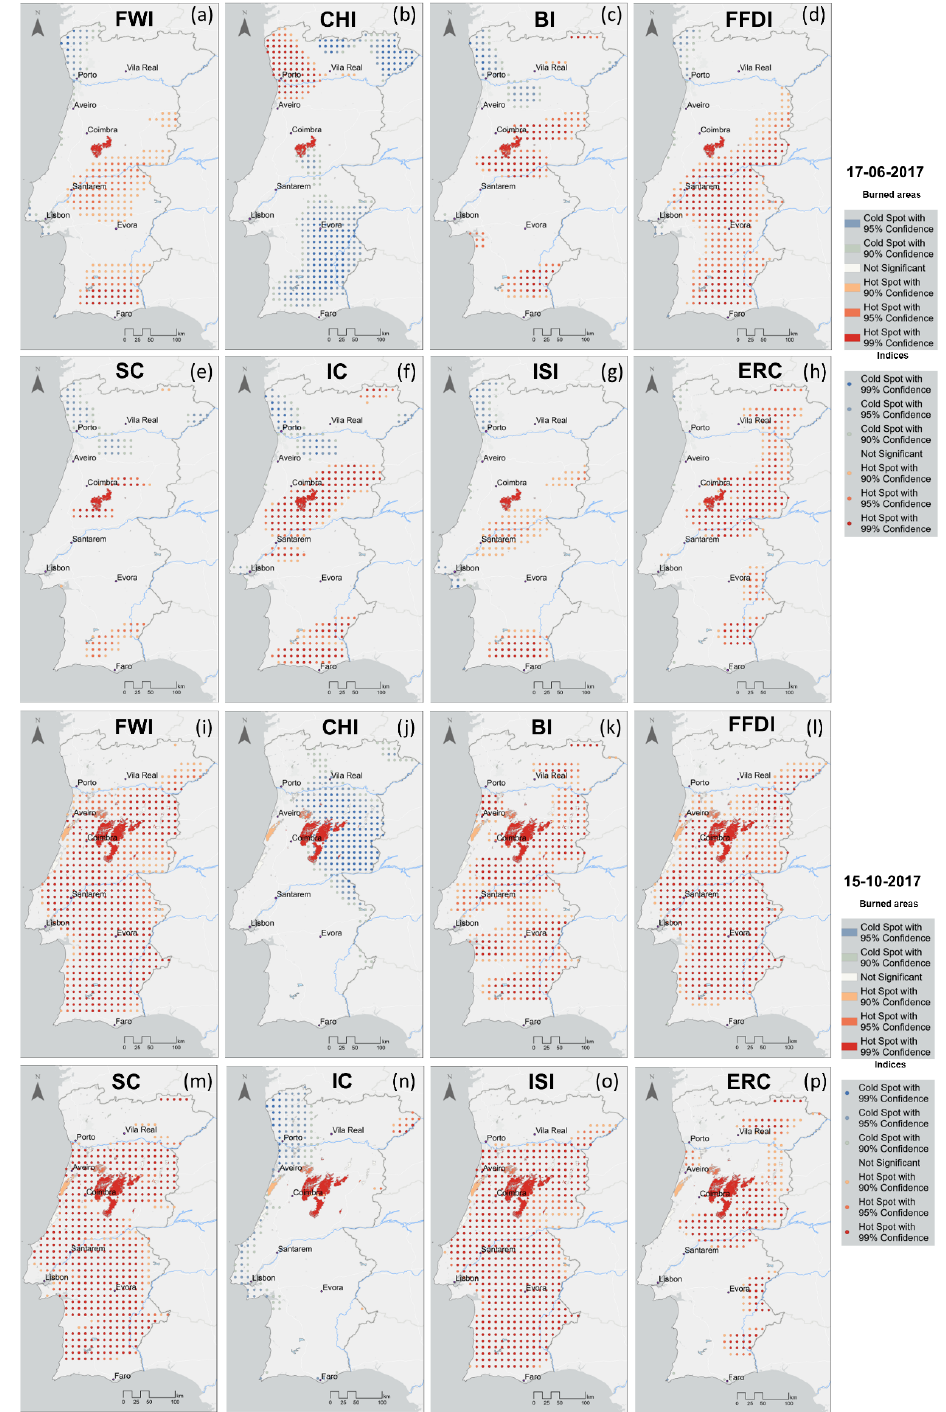
Figure A9. Hotspot analysis for the burned areas (polygons) and ( a , i ) FWI, ( b , j ) CHI, ( c , k ) BI, ( d , l ) FFDI, ( e , m ) SC, ( f , n ) IC, ( g , o ) ISI, and ( h , p ) ERC (point-by-point) for 17 June (upper rows), and 15 October, 2017 (lower rows) (Note that for both cases the scale ranges from dark red for hot spots with 99% confidence, non-significant in white (clear areas in the maps), to dark blue for cold hot spots with 99% confidence; in between 95% and 90% confidence hot (red scale)/cold (blue scale) spots can also be identified; see Section 2.4 for further details).